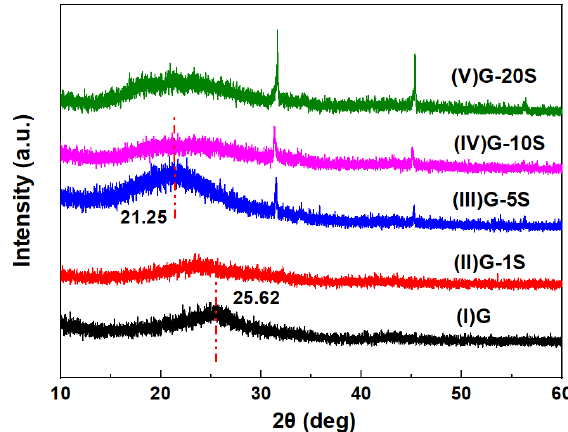
Figure 6. Sepcular 2θ XRD patterns of G, G -1S, G-5S, G-10S, and G-20S.